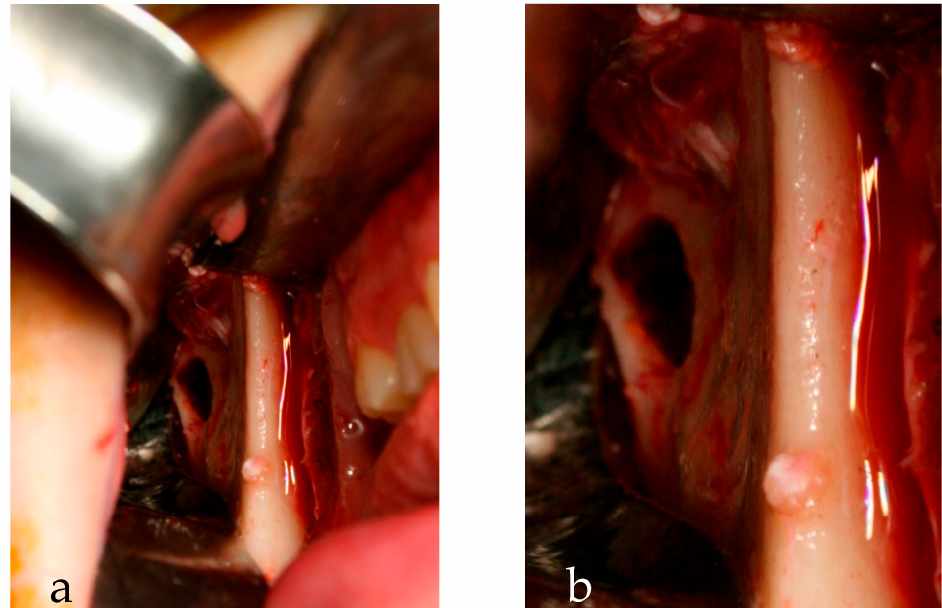
Figure 4. Intra-operative pictures. ( a ) Mandibular bone defect after surgical excision, and ( b ) a particular view.